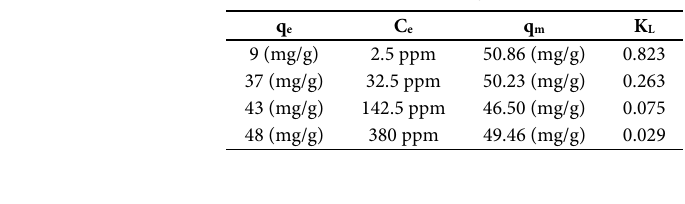
Table 3 Calculated Langmuir